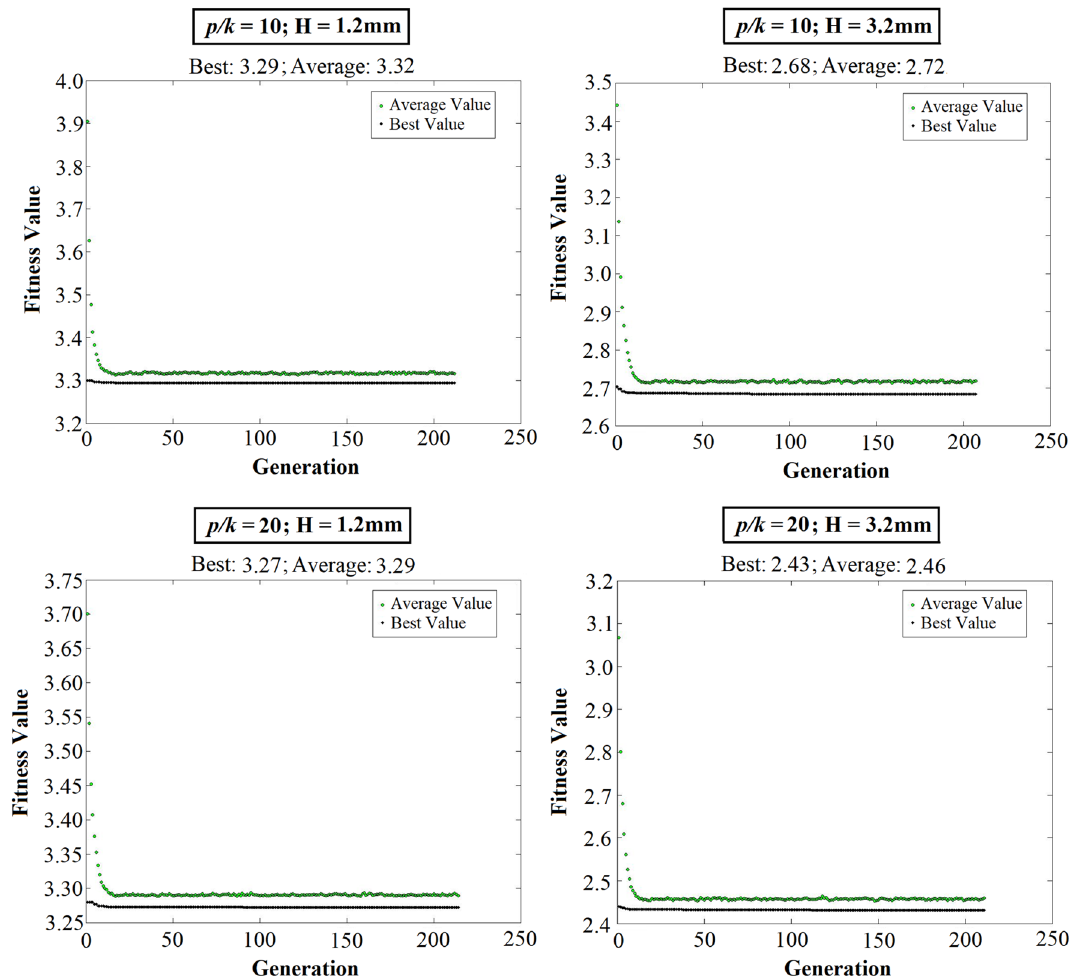
Fig. 12 Fitness value plot from genetic algorithm-based simulations for crossover rate 0.5 and mutation rate 0.05